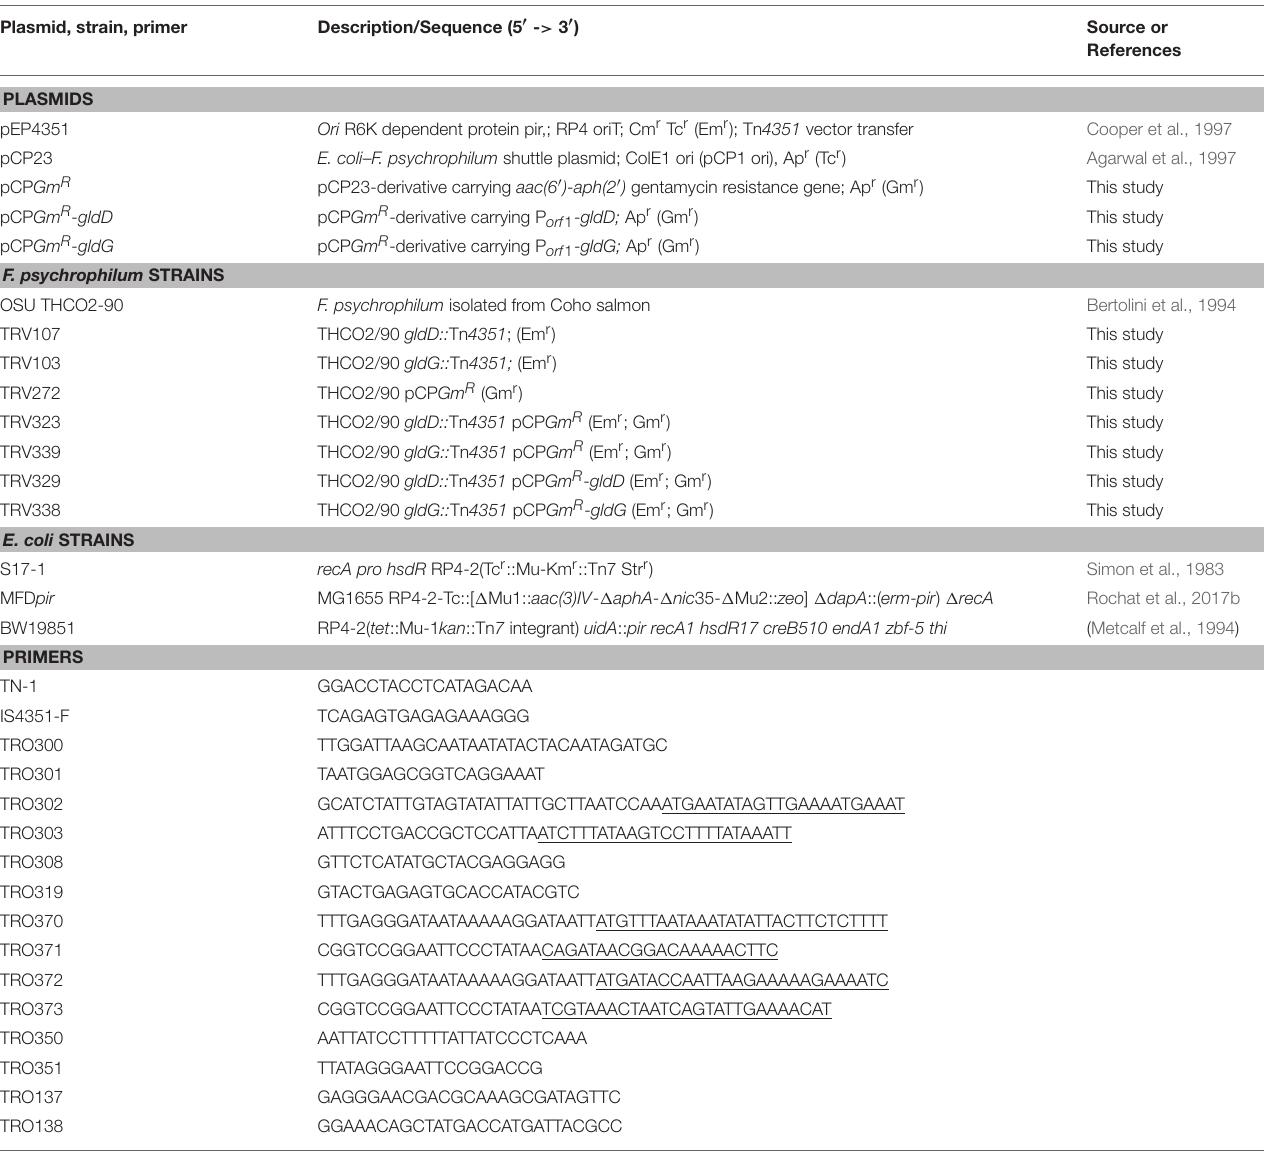
TABLE 1 | Bacterial strains, plasmids, and primers used in this study. Plasmid, strain, primer Description/Sequence (5 ′ - > 3 ′